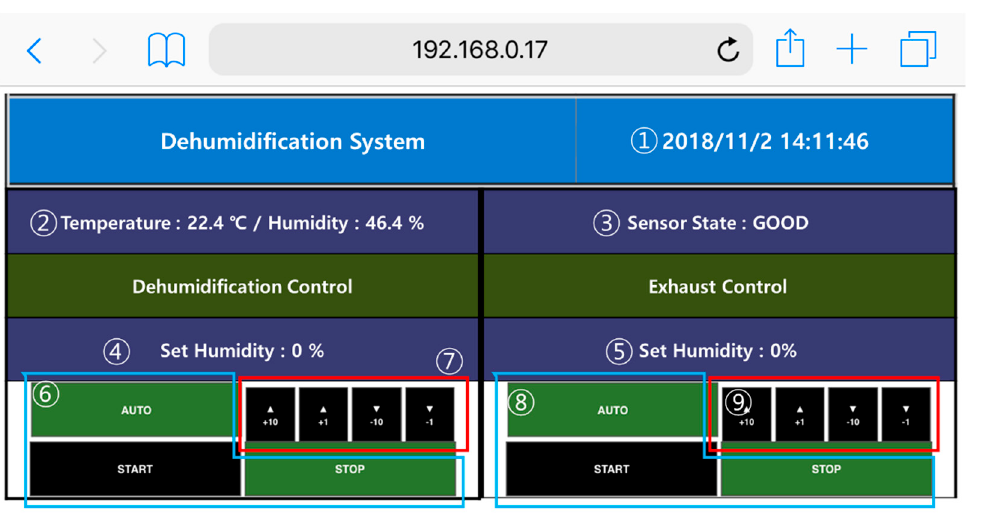
Figure 7. Web page for remote control. Table 4. Operating explanation on web page.